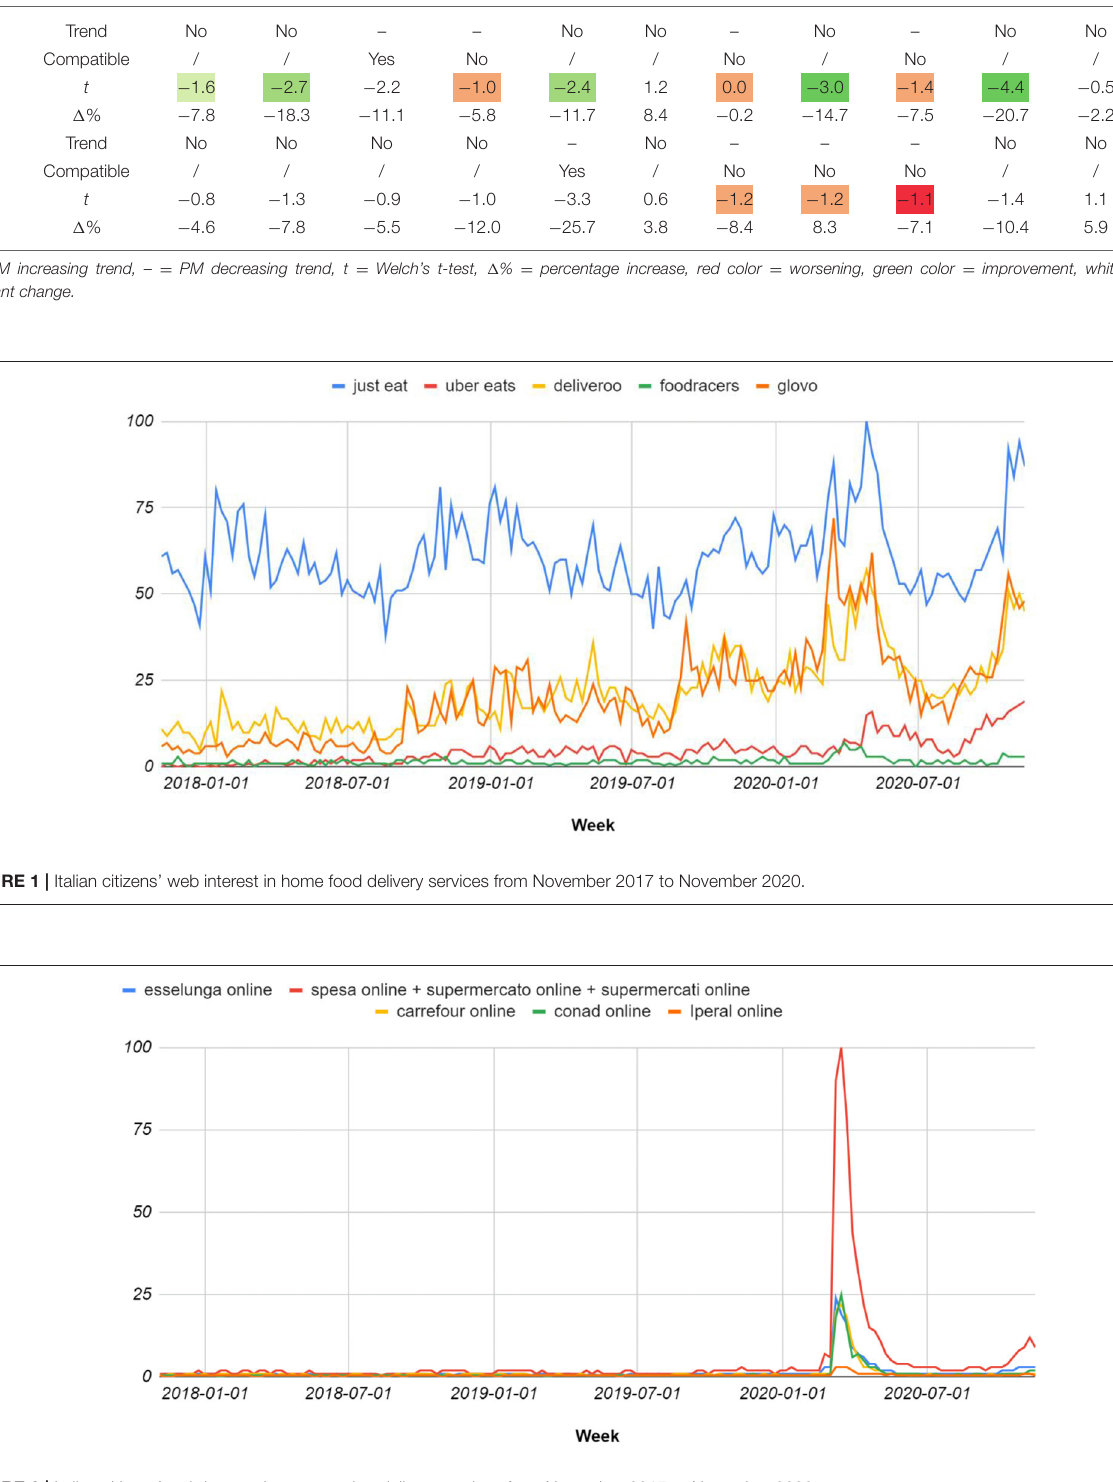
Frontiers in Sustainability |